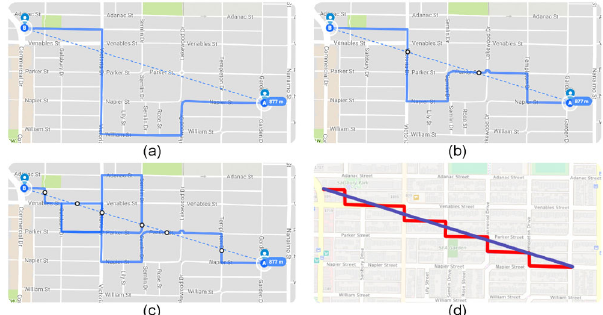
Fig. 4 Approximating a single line shape with Google Maps. Using just the start and end points creates a route that significantly deviates from the diagonal line (a). Adding more points (b). With too many points, the line starts to incoprporate numerous U-turns to guarantee that each way-point is reached (c). Our solution is given in (d).